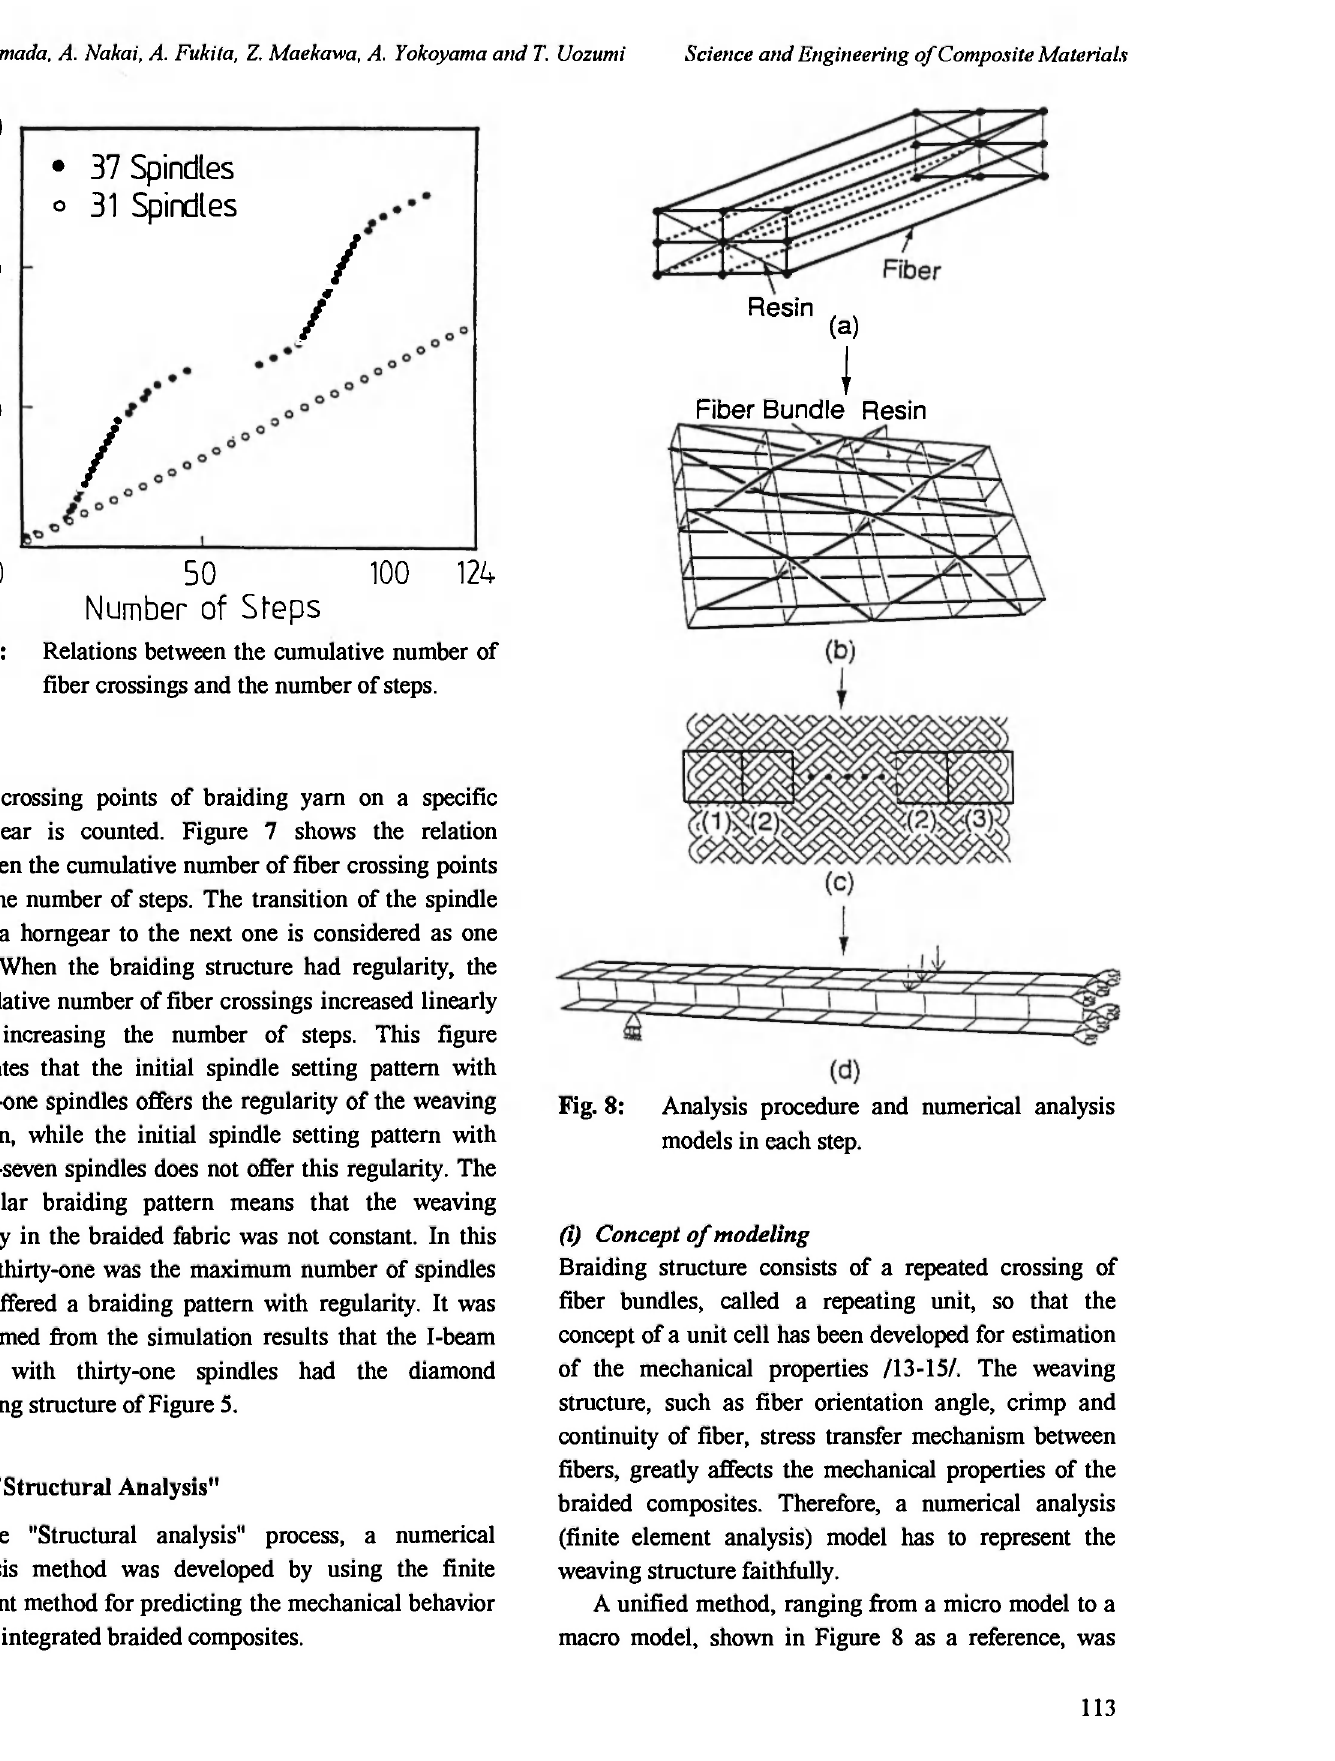
Fig. 7: Relations between the cumulative number of fiber crossings and the number of steps.